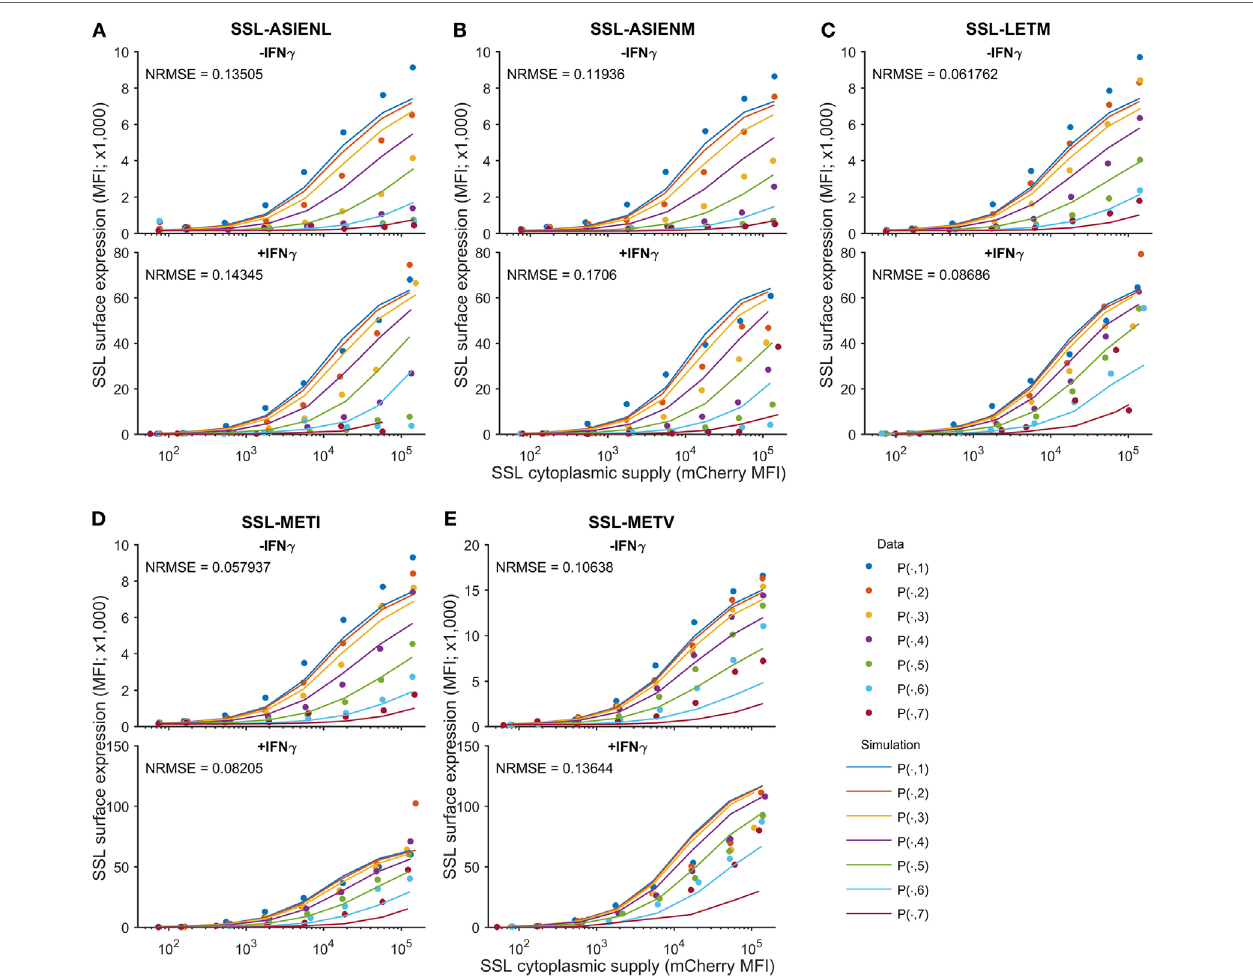
FigUre 4 | Predicting cell surface presentation between peptide competitors. Using the calibrated model, cell surface presentation was predicted for SSLENFRAVY competing against variants of the ASNENMETM peptide, by changing the peptide off-rates to the measured values in Table 1 . Shown are predictions and measurements for cell surface presentation of SSLENFRAYV, both in untreated (top panels) and IFN γ -treated (bottom panels) cells, when competing against ASN variant peptides (a) ASIENLETM, (b) ASIENMETM, (c) ASNENLETM, (D) ASNENMETI and (e) ASNENMETV. Predictions of the cell surface presentation of ASNENMETM variants are shown in Figure S8 in Supplementary Material. Different colored traces represent different cytoplasmic levels of the competing ASNENMETM variant, as indicated in Figure 1b . The normalized root mean-squared error (NRMSE) between the data and the simulation is also shown for each